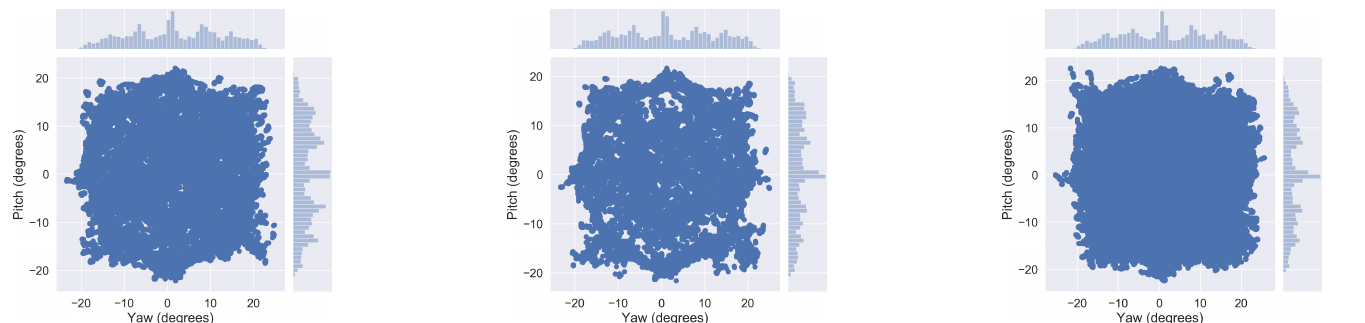
Figure 3. 2D gaze angle distributions for train ( left ), validation ( center ) and test ( right ) splits of the Gaze Prediction data